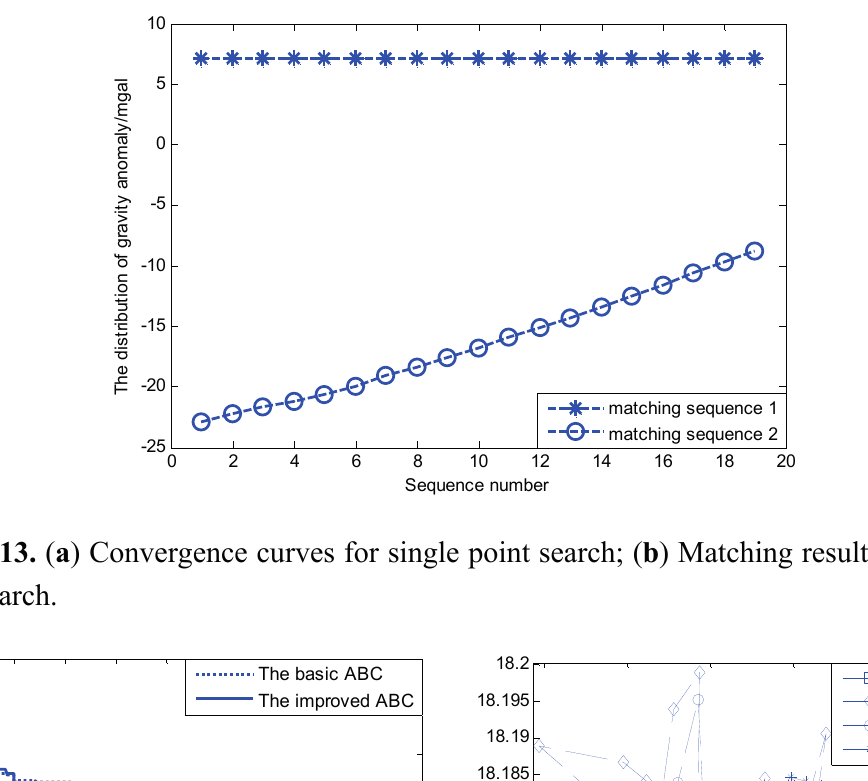
Figure 12. The distribution of the gravity anomaly for different matching sequences.